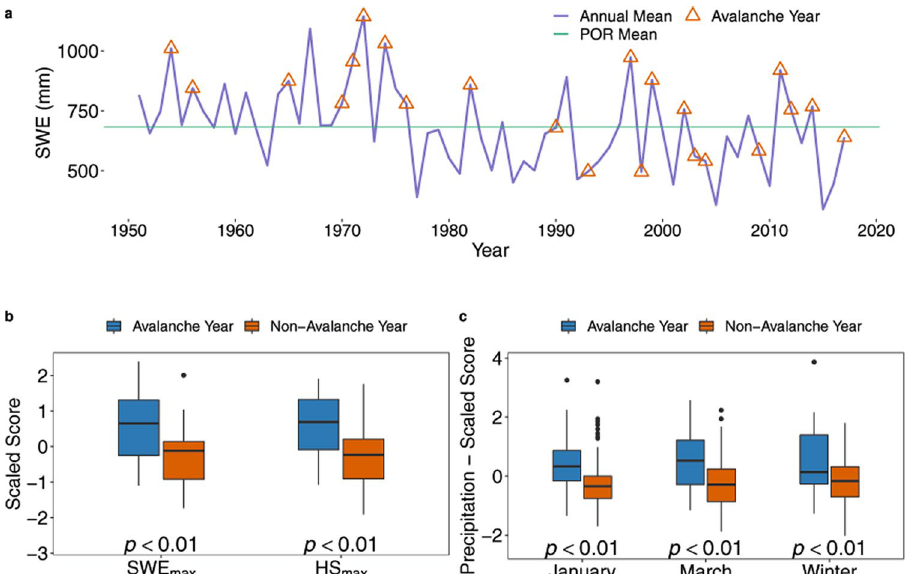
Figure 2. Time series and boxplots of snowpack and winter precipitation. Time Series of snow water equivalent (SWE) ( a ) with avalanche years represented by red triangles and the annual mean SWE for the period of record (green horizontal line). SWE values between avalanche (blue box) and non-avalanche (red box) years for ( b ) regional maximum snow water equivalent (SWE max ) and maximum snow depth (HS max ), and ( c ) significant monthly and winter precipitation totals. Horizontal black lines in the boxplots represent median values. ( a ) Displays only 23 out of 30 identified avalanche years because the analyzed period of record of SWE and HS begins in 1950 due to sparse data prior to 1950.